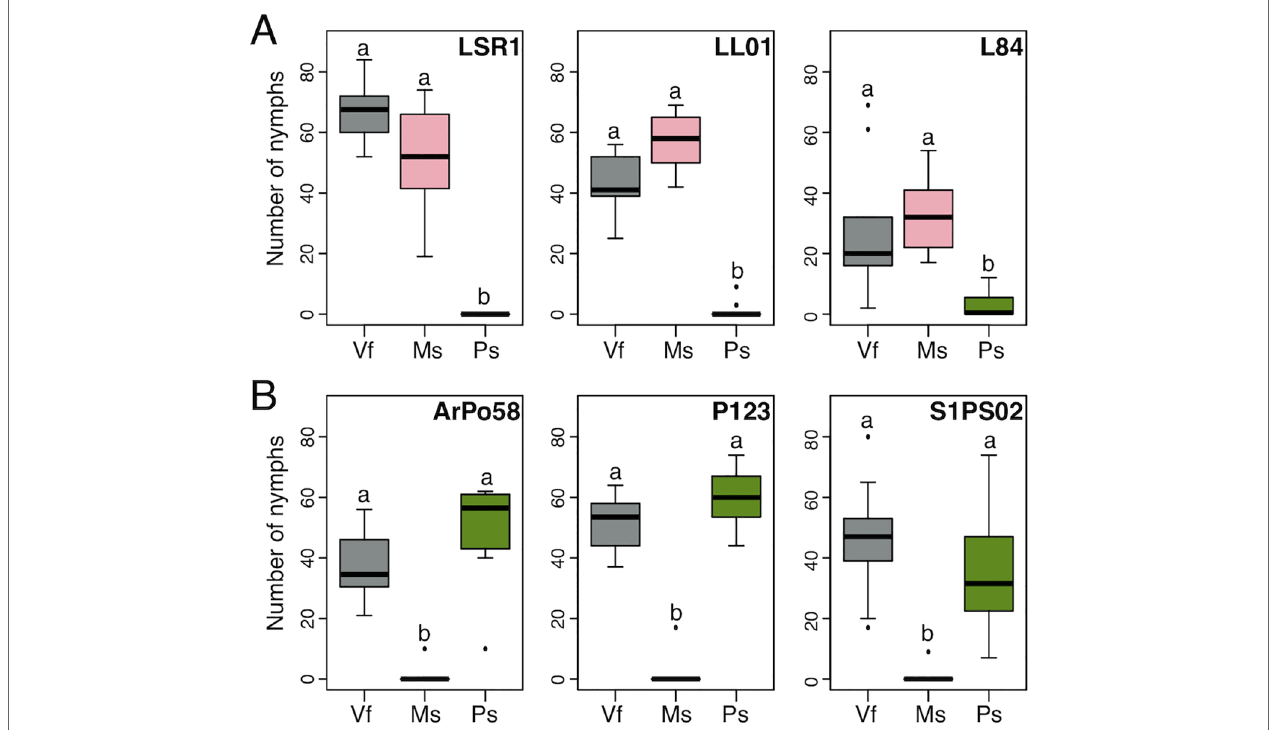
FIGURE 1 | Acyrthosiphon pisum lines that belong to the alfalfa (A) or pea (B) biotype show distinct host specificity. The numbers of nymphs produced by single aphid mother during 18 days on the universal host plant Vicia faba (Vf), specific host plants Medicago sativa (Ms), and Pisum sativum (Ps) are shown. Letters above boxes indicate significant differences determined by multiple Kruskal-Wallis tests for each aphid line (in LSR1: H = 25.235, 2 d.f., P < 0.001; in LL01: H = 26.479, 2 d.f., P < 0.001; in L84: H = 21.499, 2 d.f., P < 0.001, in ArPo58: H = 25.778, 2 d.f., P < 0.001; in P123: H = 23.416, 2 d.f., P < 0.001 and in S1PS02: H = 23.179, 2 d.f., P <